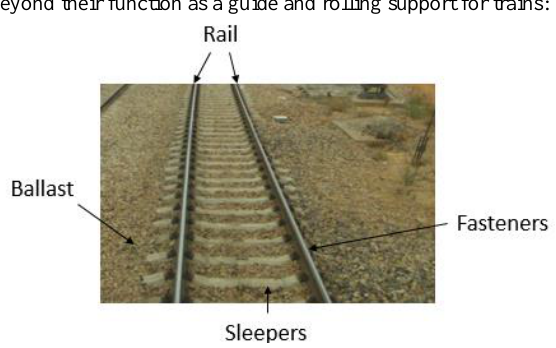
Fig. 1. Components of a railway track